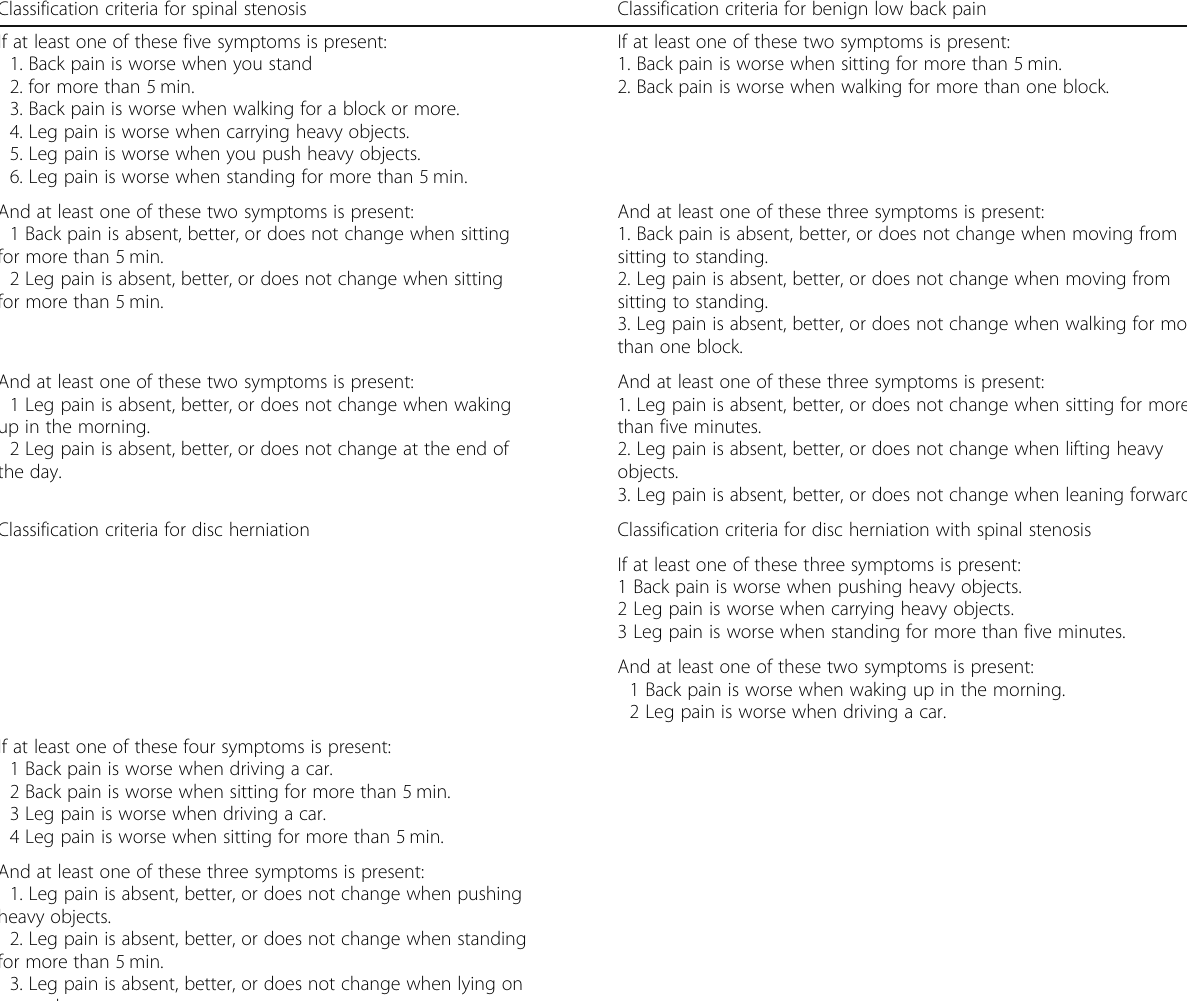
Table 2 Diagnostic classification criteria through PRAP Classification criteria for spinal stenosis Classification criteria for benign low back pain